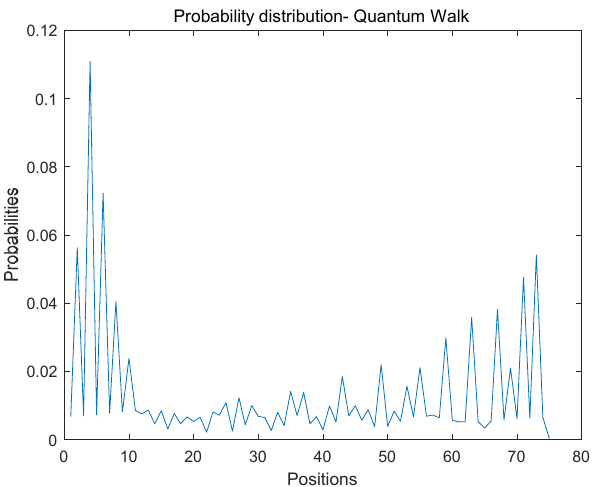
Figure 1. 1D discrete quantum walk probability distribution on a circle.